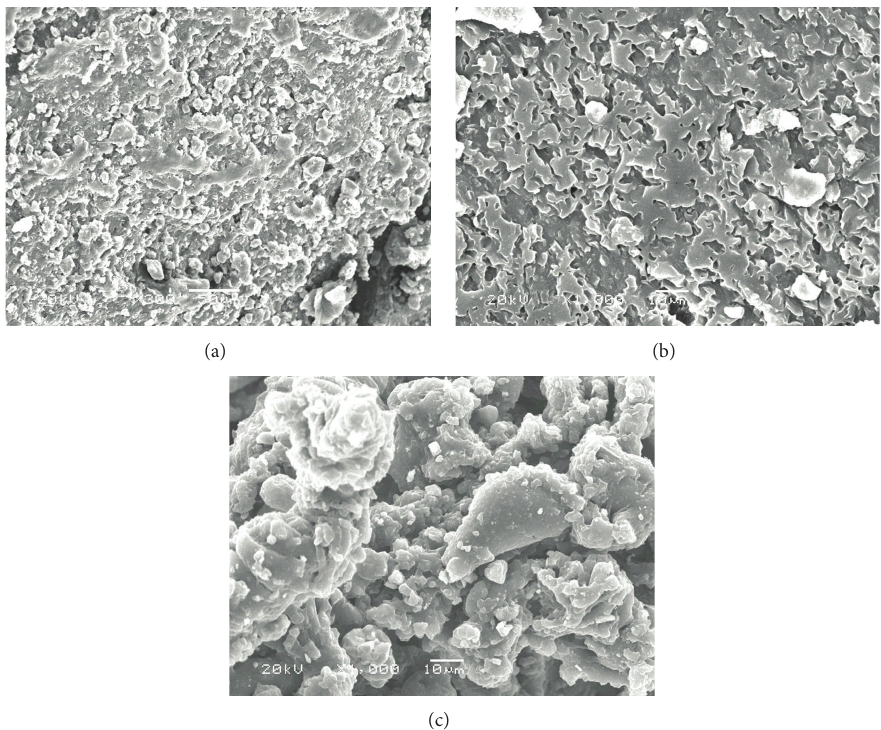
Figure 3: Scanning electron micrographs of waste tire: (a) Type-I, (b) Type-II, and (c)